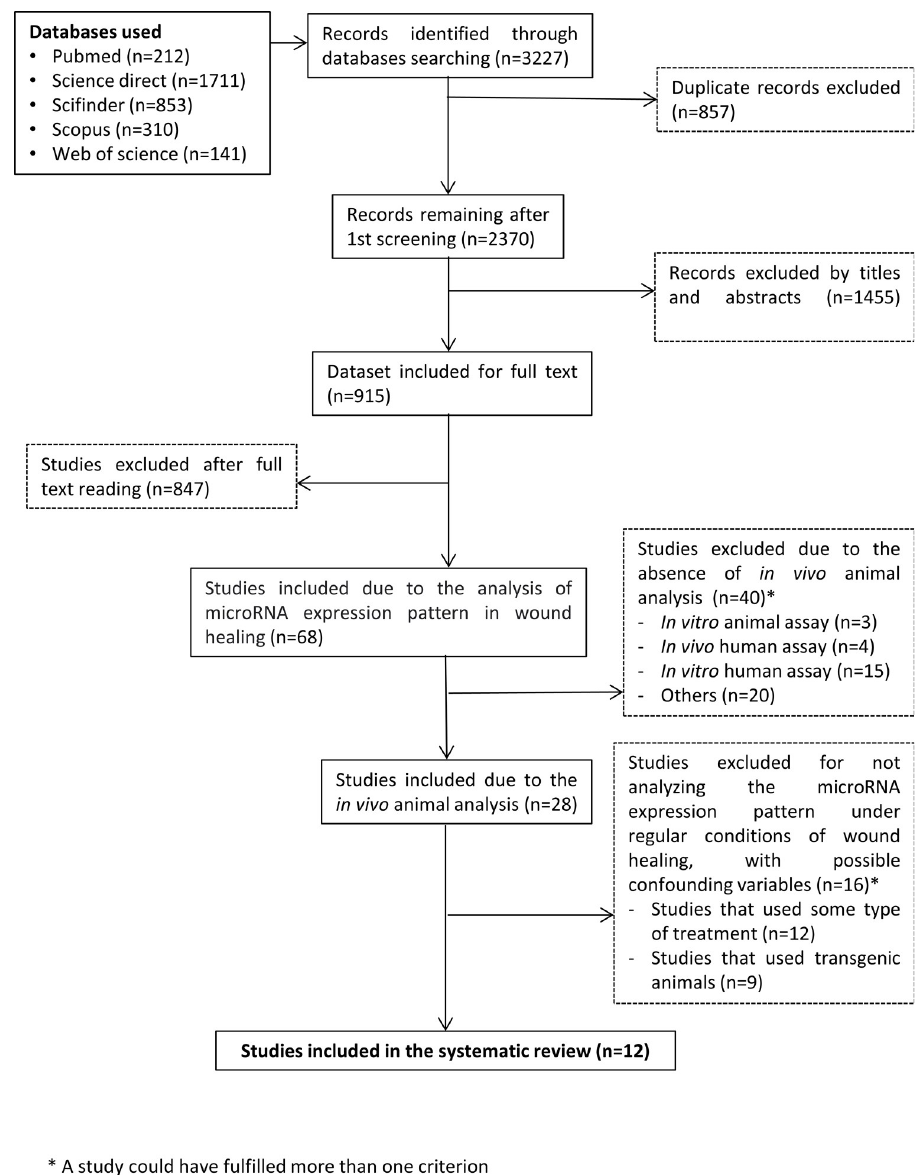
Fig 1. Flow diagram of study selection. Flow diagram of the study selection process according to PRISMA Statement. * A Study could have fulfilled more than one criterion.